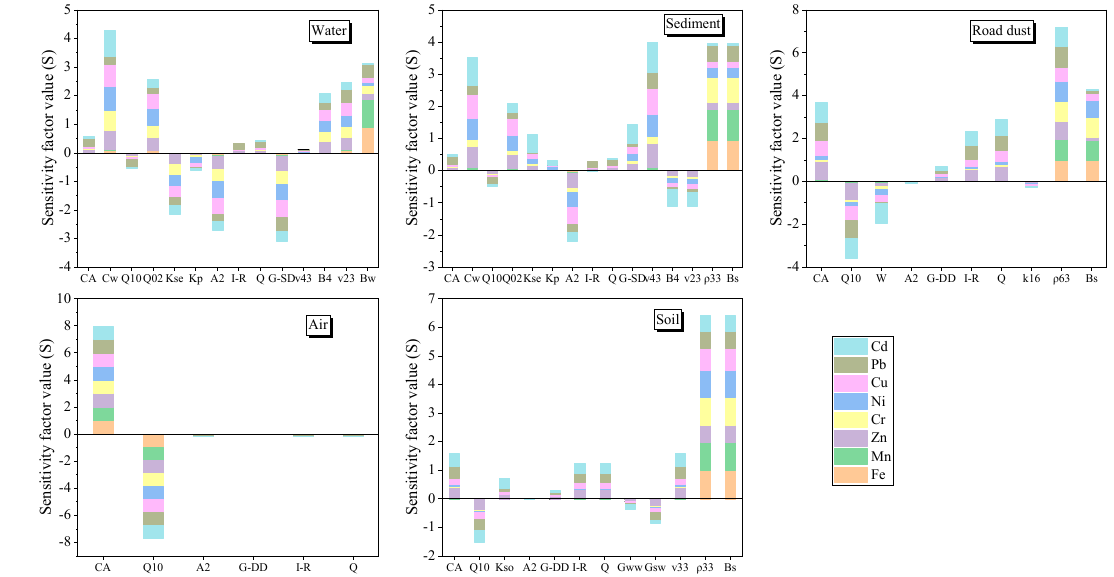
ffi cients for the